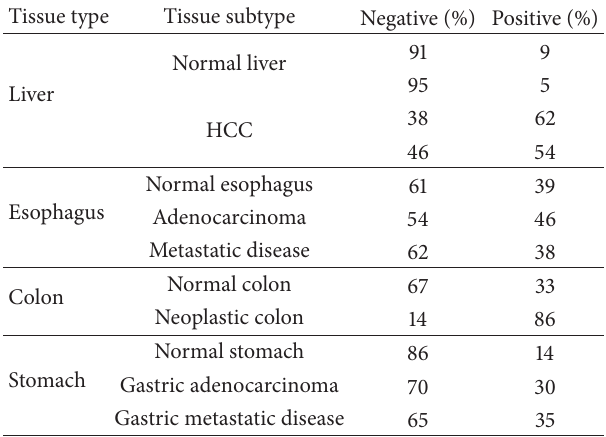
Table 1: Summary of YAP activation in different human digestive system cancers.